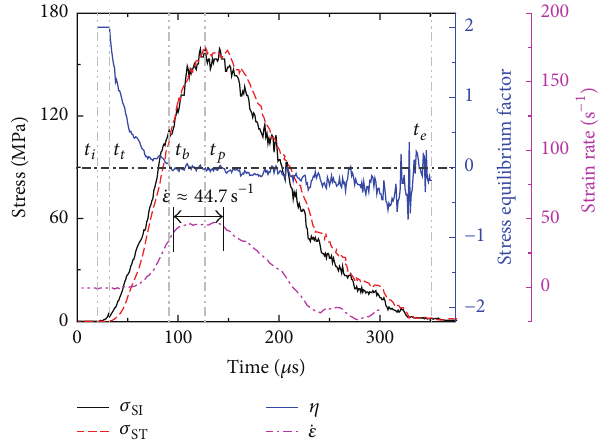
Figure 5: Stress equilibrium at the two ends of prismatic specimen under impact